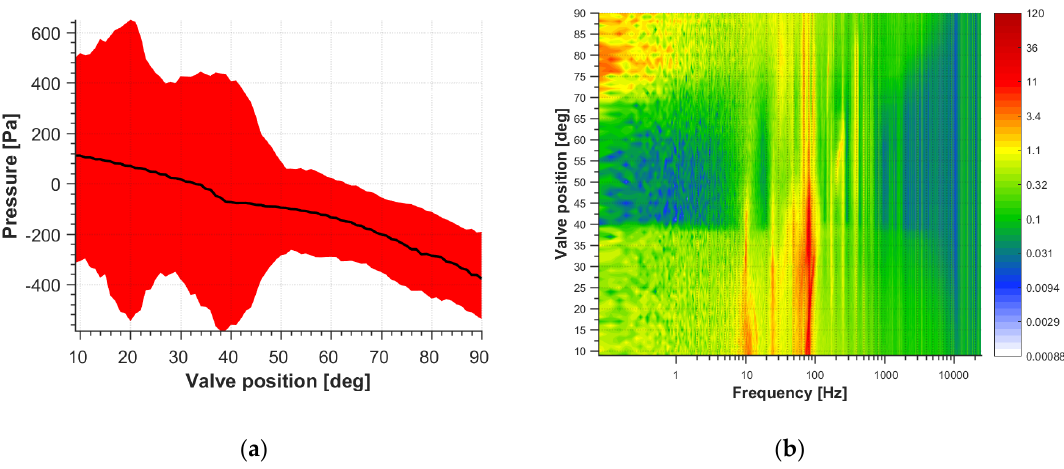
Figure 9. Pressure variation depending on the valve position measured at the inlet at impeller rotational speed 95 Hz. ( a ) The left plot represents the min-to-max plot (red) and the pressure average value (black). ( b ) The right plot represents the spectral map with the colormap in the logarithmic scale.